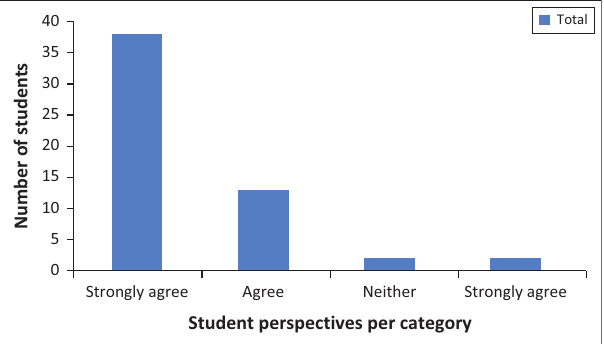
FIGURE 6: Post-workshop understanding of the required assignment